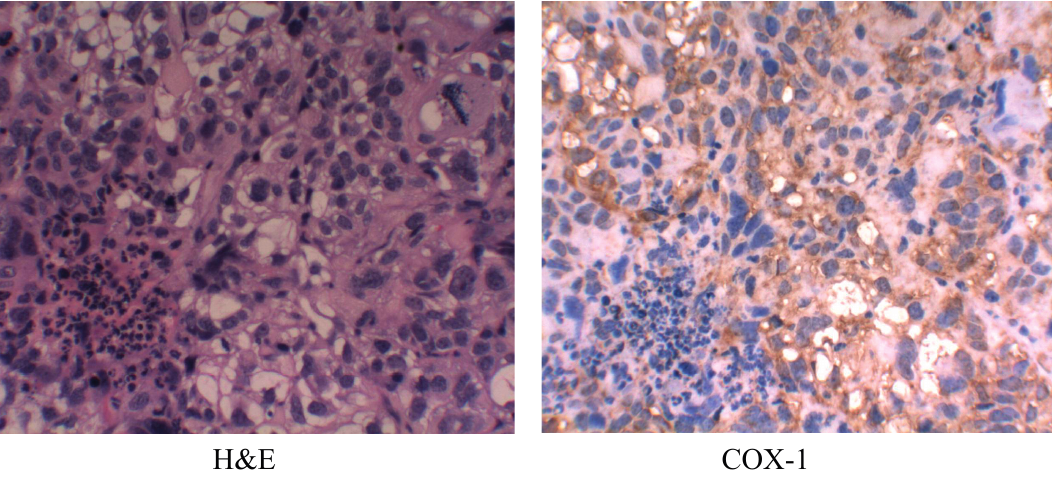
Figure 7. Immunohistochemical analysis of cyclooxygenase-1 (COX-1) expression in untreated tumor samples. Magnification is 100×.